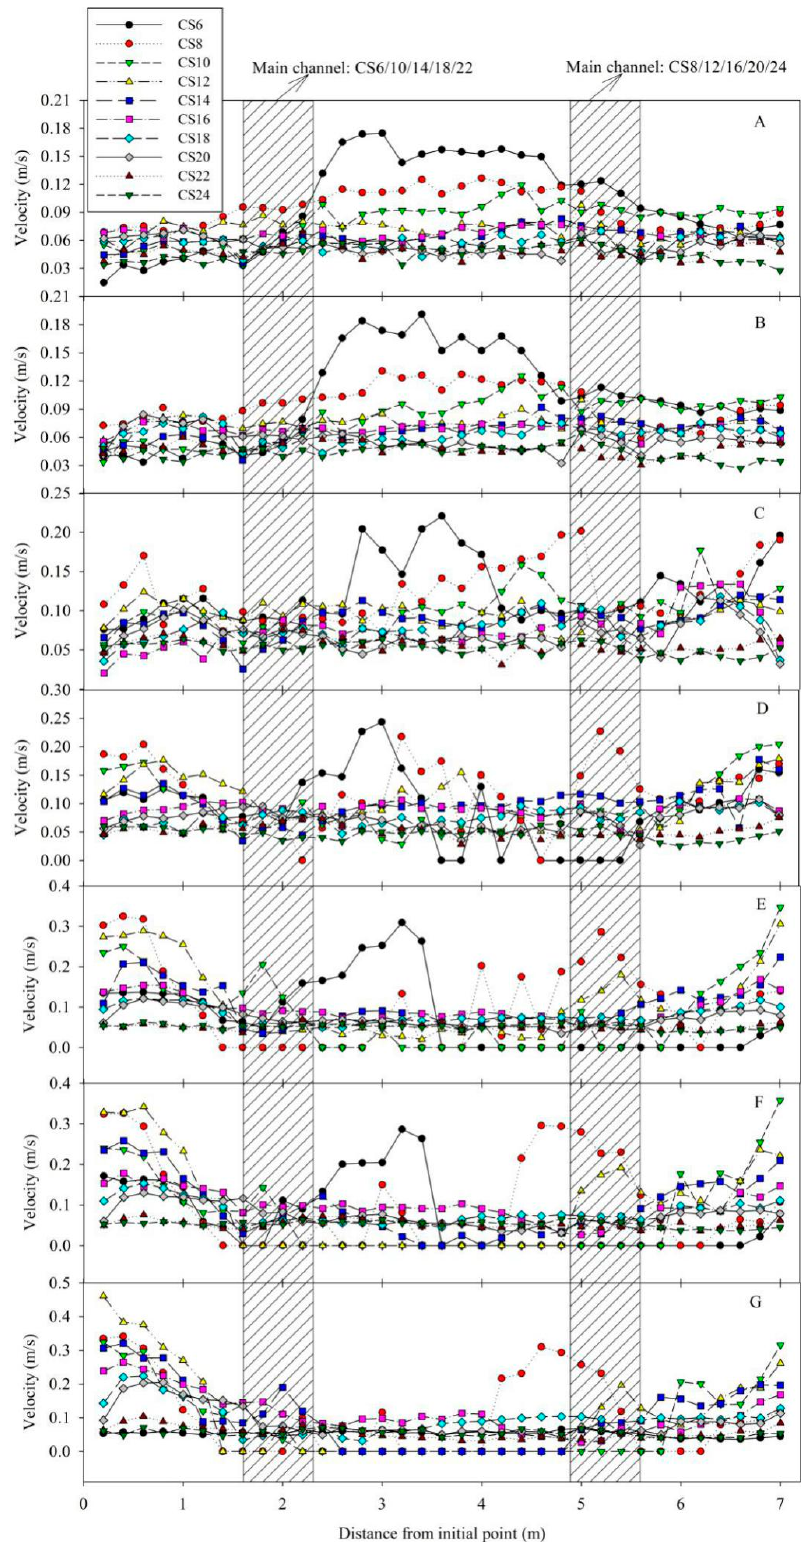
Figure 3. Transverse velocity distribution of each section under different working conditions, A-G represented conditions 1–7, respectively. The graphs correspond to the different conditions 1–7 described in Table 1.